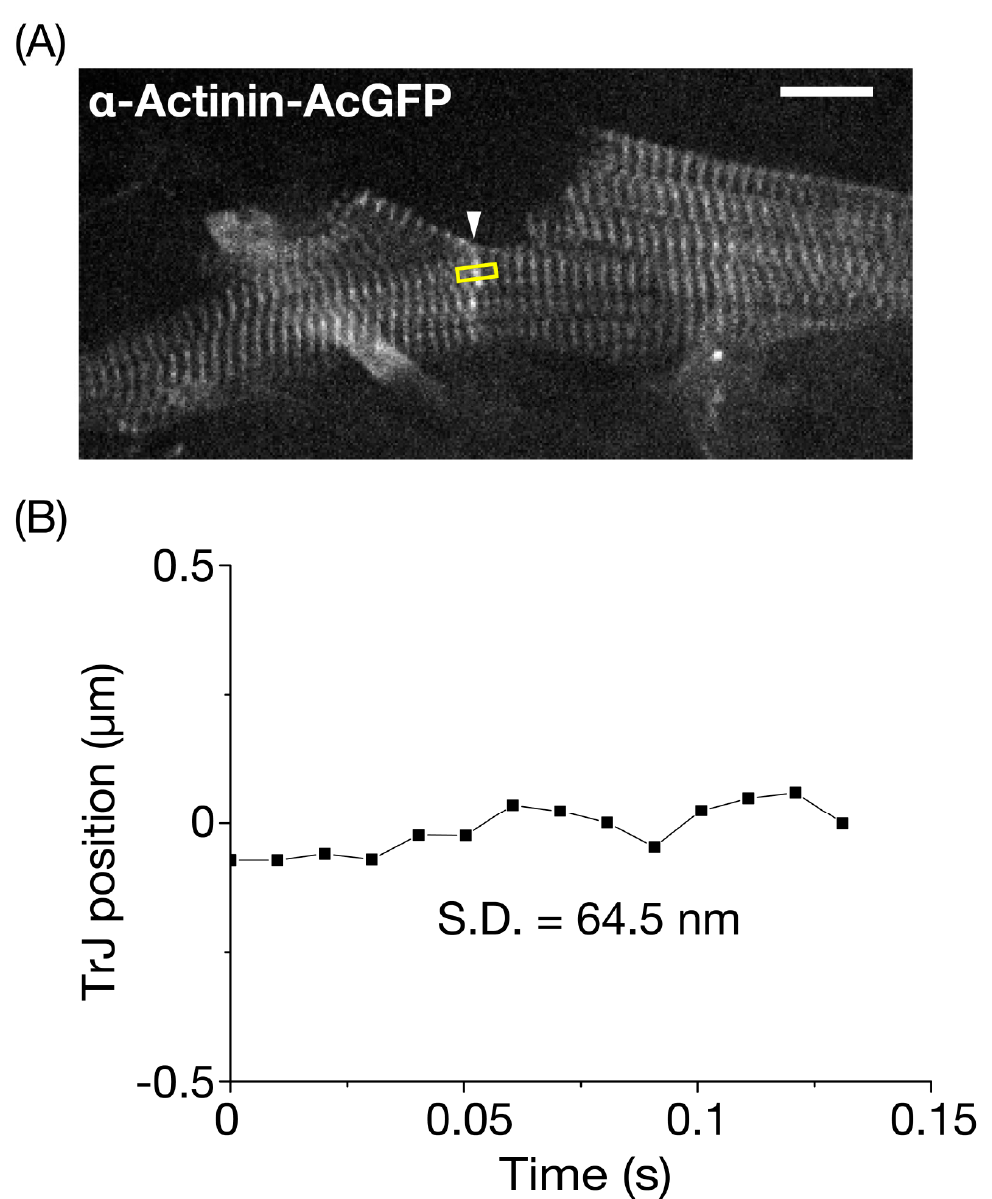
Figure 4. Precision analysis for the longitudinal position of the transitional junction in the resting mouse left ventricle. ( A ) In vivo confocal image of neighboring myocytes revealed transitional junctions (TrJ), which appeared as a singlet band with a high fluorescence signal (arrow, see also description in text). α -Actinin-AcGFP was expressed in myocytes in the surface of the left ventricle (LV) based on our previously reported procedure (see Materials and Methods). The longitudinal fluctuation of an TrJ section (width, 5 pixels ( = 1.05 µ m)) in the yellow rectangle was analyzed under the arrested condition via deep anesthesia with > ~5% isoflurane. Bar on the top right indicates 10 µ m. ( B ) Time course of fluctuation of the longitudinal position of the TrJ section in ( A ). The SD of fluctuation was 64.5 nm during the course of observation (0.13 s). The heart in an open-chest mouse was excited using a laser at 488 nm. Imaging was performed at 99 frames /